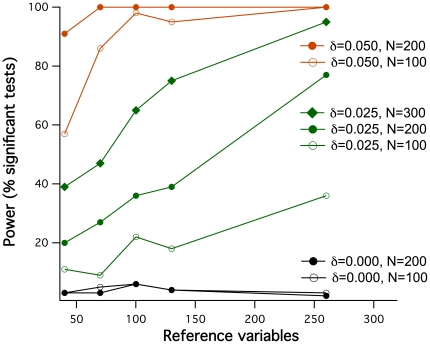
Power of coreferentiality detection in respect to the number of reference variables used.100 respective data sets were simulated for different sample sizes N, different reference data dependency degrees δ (see insert) and either 40, 70, 100, 130 or 260 reference variables, and tested for coreferentiality with the permutation test described. The occasional deviation from monotonous behavior in the curve representing δ = 0.025, N = 100 is due to stochasticity.